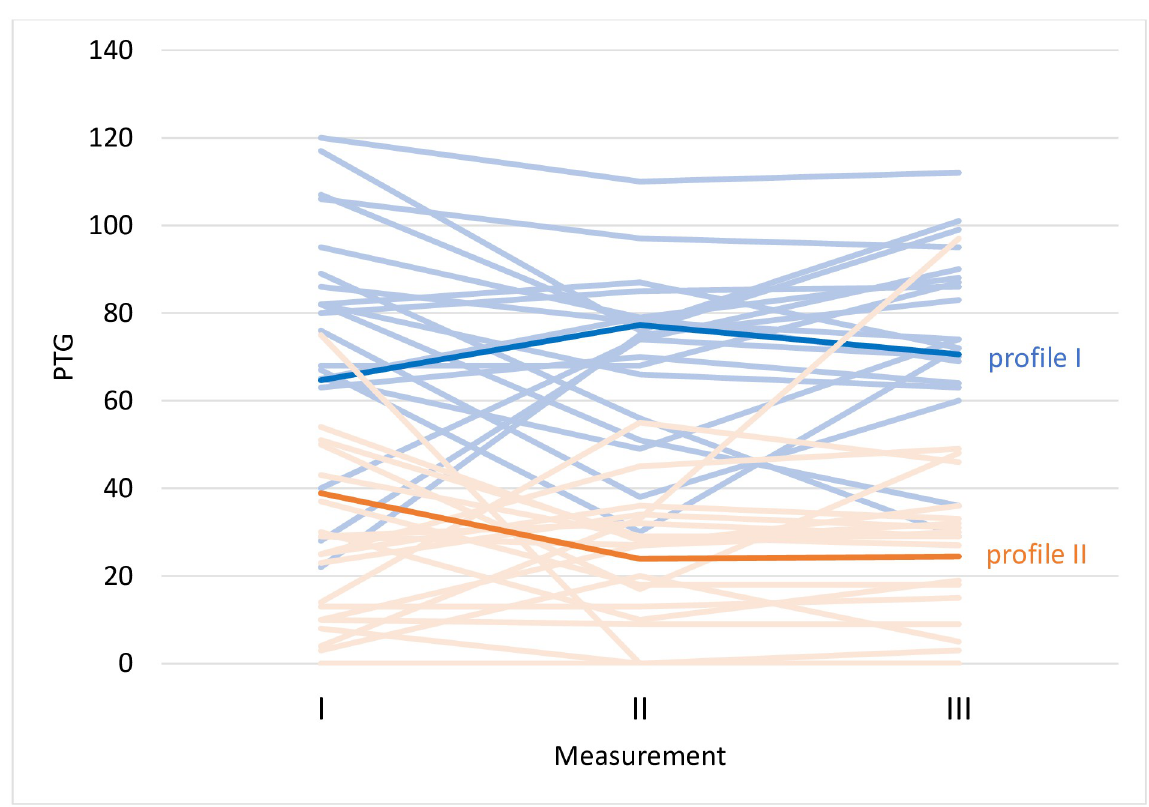
Fig 1. Detected profiles of trajectories regarding changes in PTG. The two extracted profiles detected in at least 20% of cases in the sample are highlighted (i.e., the model with the lowest value of Bayesian Information Criterion (BIC)).